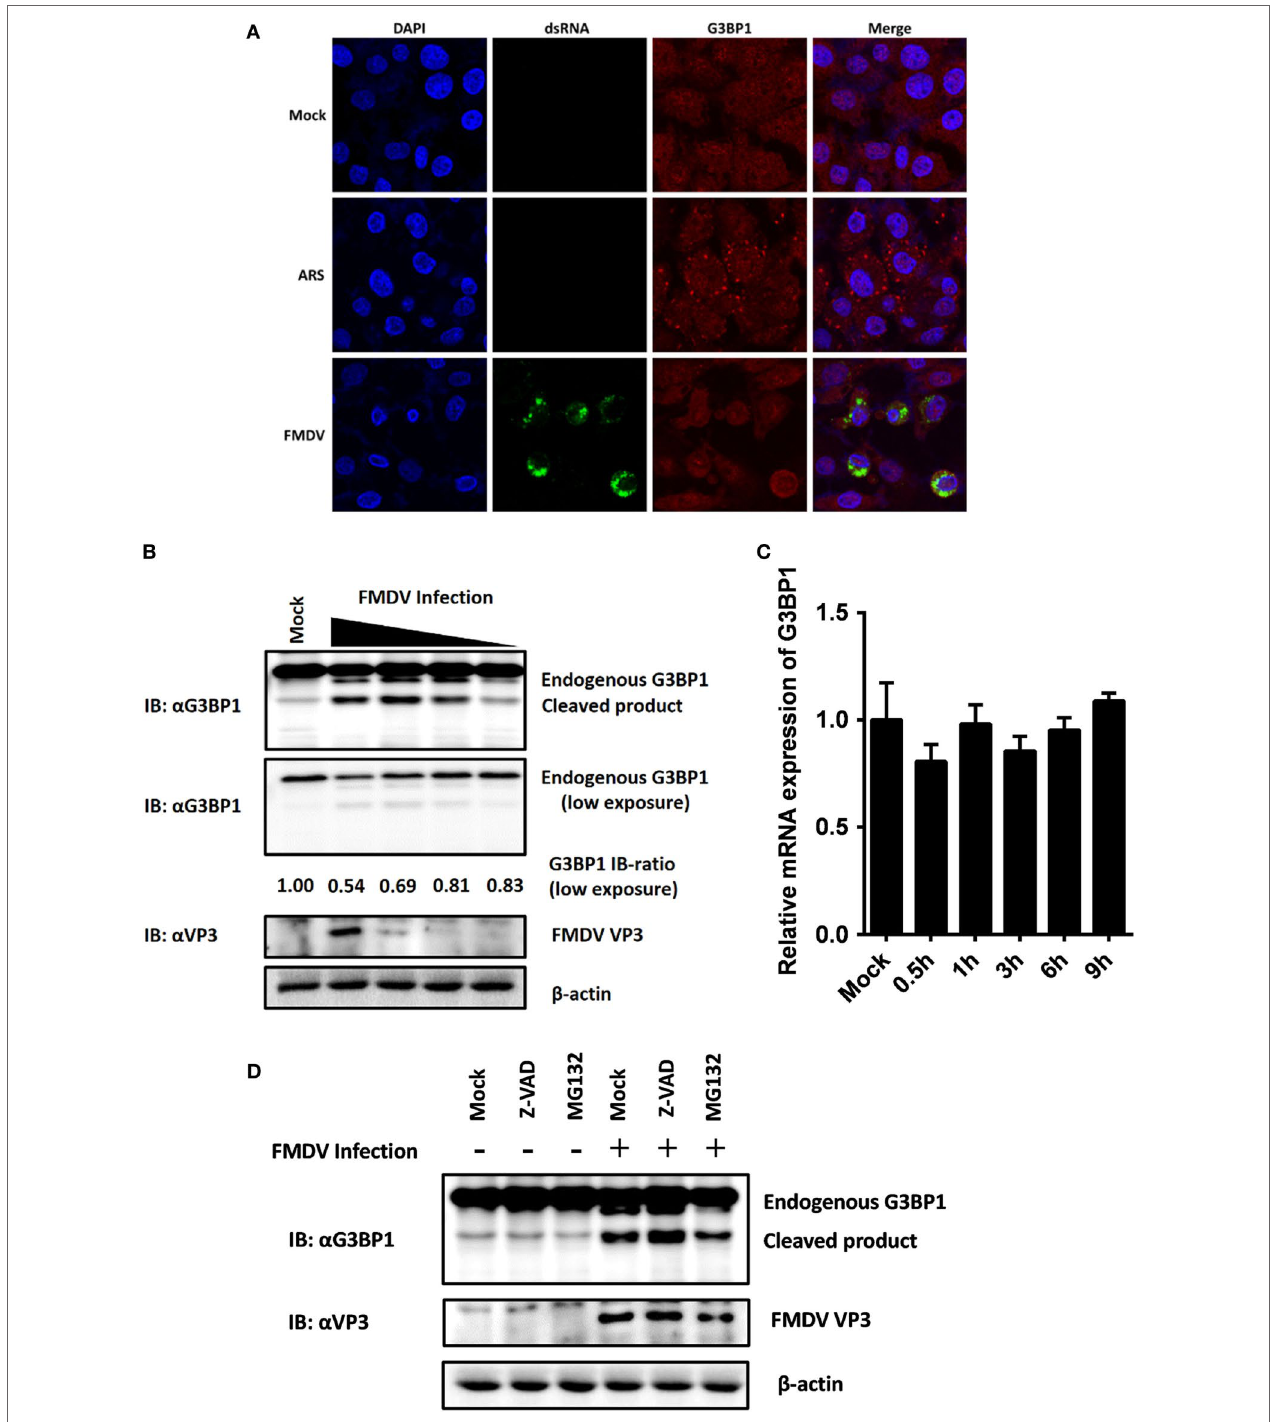
FigUre 5 | Foot-and-mouth disease virus (FMDV) infection induces G3BP1 cleavage. (a) IBRS-2 cells were mock-infected or infected with FMDV (MOI = 5). At 6 h post-infection (hpi), indirect immunofluorescence assays were performed. Arsenite, an inducer of stress granules formation, was used to stimulate cells for 1 h. The cells were fixed and incubated with a monoclonal antibody against virus double-stranded RNA (green) and a polyclonal antibody against G3BP1 (red). The nuclei of cells were stained with DAPI (blue). (B) IBRS-2 cells were mock-infected or infected with FMDV at different MOIs (0.04, 0.2, 1, and 5 MOI), lysed at 6 hpi, and analyzed for G3BP1 protein levels by western blotting. Immunoblotting ratios (infection/control) were quantified by ImageJ. (c) IBRS-2 cells were mock-infected or infected with FMDV for different times (0.5, 1, 3, 6, and 9 h), lysed and analyzed for G3BP1 mRNA levels by real-time reverse transcriptase-PCR. (D) IBRS-2 cells were mock-infected or infected with FMDV (MOI = 5). MG132 or zVAD-FMK was added to the indicated group at a final concentration of 20 µM. Cell lysates were prepared 6 h after infection/treatment and analyzed by western blotting.